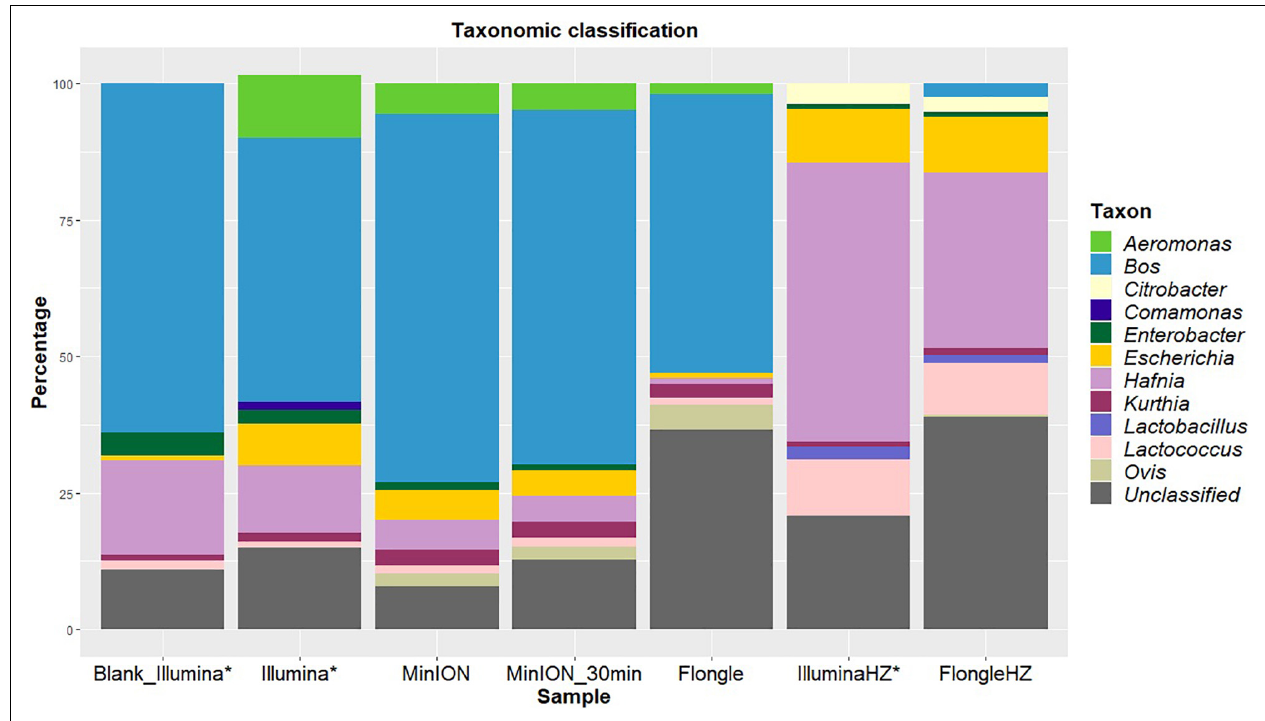
FIGURE 1 | Percentages of reads classified to the genus level using Kraken2 (taxonomic classification tool) from blank and spiked beef samples extracted with two DNA extraction kits (one involving host removal, HZ) and sequenced on Illumina (MiSeq), MinION, or Flongle, with in-house databases of mammals, archaea, bacteria, fungi, human, protozoa, and viruses. The data for Illumina sequencing (*) was published in Buytaers et al. (2020). Light blue represents the proportion of “Bos” corresponding to beef reads. Yellow indicates the presence of “Escherichia” in the sample. The reads that could not be classified to the genus level for mammals, archaea, bacteria, fungi, human, protozoa, or viruses are represented in